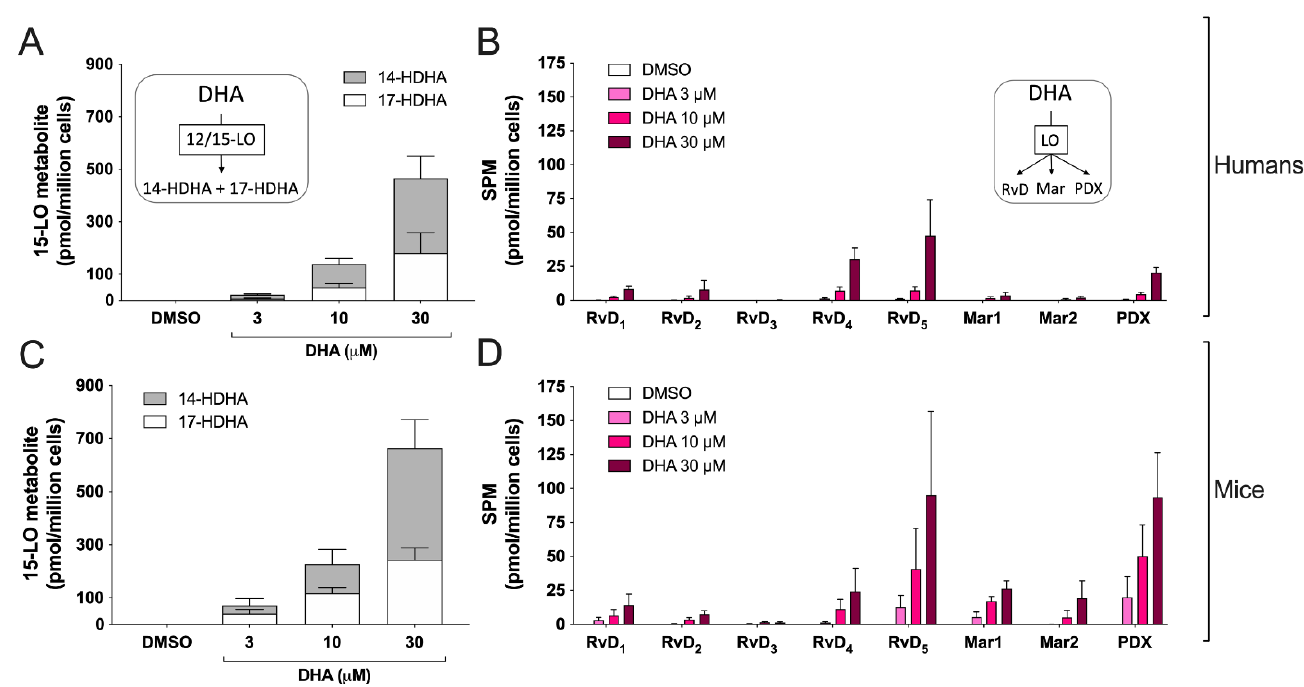
Figure 3. Biosynthesis of docosanoids by human and mouse eosinophils. EOS suspensions (5 × 10 6 cells/mL, 37 °C) were incubated with DMSO or increasing concentrations of DHA for 15 min. Incubations were stopped by adding one volume of cold (−20 °C) MeOH containing the internal standards. Samples were then processed and analyzed for docosanoids by LC-MS/MS as described in Materials and Methods. ( A , B ) Results are the mean (± SEM) of 5 independent experiments using human eosinophils from asthmatic donors. ( C , D ) Results are the mean (±SEM) of 7 independent experiments using bone marrow-derived mouse eosinophils.